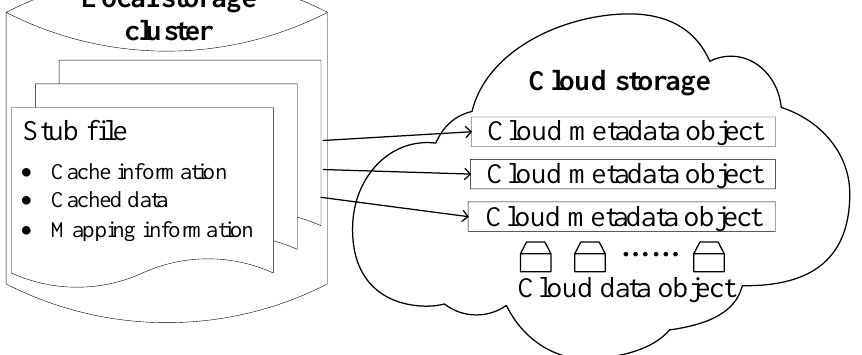
Figure 3. Diagram of stub file and cloud object.